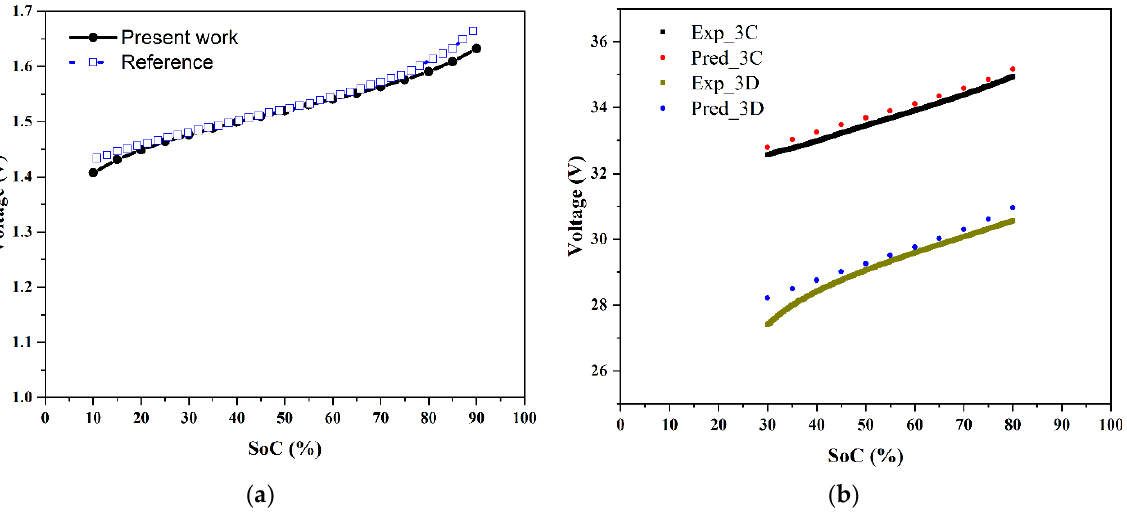
Figure 7. Predictions of the present model: ( a ) comparison of the cell voltage variation with SoC at a current density of 80 mA/cm 2 with the predictions of a more comprehensive overpotential model [19], and ( b ) a comparison of the predicted voltage variation with respect to SoC during charging and discharging at 3 kW with data from the present experiments.